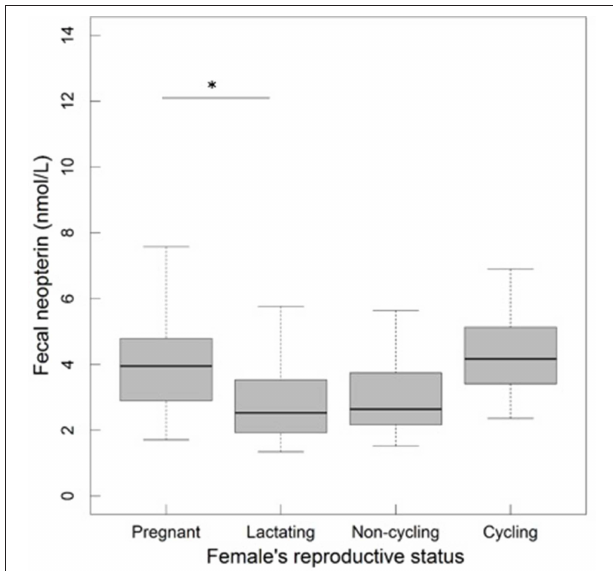
FIGURE 4 | Fecal neopterin concentrations (raw data) in relation to female reproductive state ( N = 32 individuals and 149 samples including 25 from pregnant females, 48 from lactating females, 62 from non-cycling females and 14 from cycling females; mean number of samples per female ± SD: 4.7 ± 4.5; range: 1–23). The bottom and top of the box, respectively, represent the 25th and 75th quartiles, and the bold horizontal line represents the median. The significance of the comparisons was evaluated by changing contrasts in each LMM. Comparisons are denoted by “*” if significant ( p < 0.05).